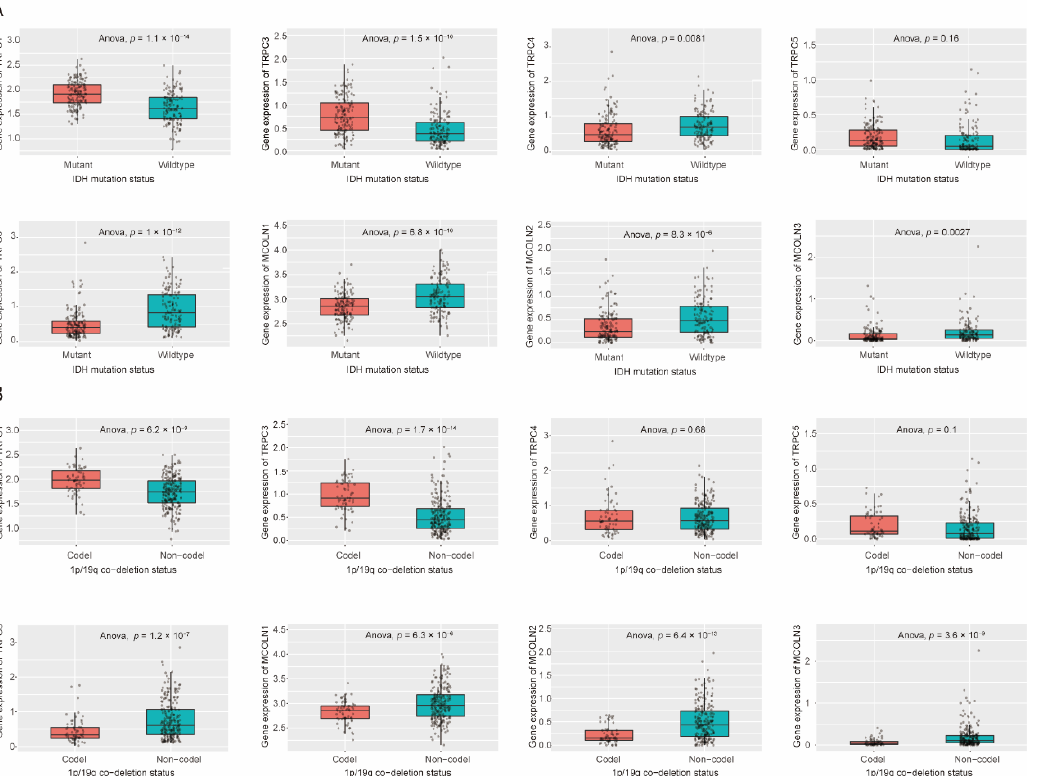
Figure 6. Expression of hub genes in IDH mutation status and 1p/19q codeletion status of glioma. ( A ) . Validation of hub gene expression levels of TRPC1, MCOLN1, MCOLN2, MCOLN3, TRPC5, TRPC4, TRPC3, and TRPC6 in different IDH mutations status of glioma using CGGA database. ( B ). Validation of hub gene expression levels of TRPC1, MCOLN1, MCOLN2, MCOLN3, TRPC5, TRPC4, TRPC3, and TRPC6 in different 1p/19q codeletion status of glioma using CGGA database. The bottom and top of the boxes are the 25th and 75th percentiles, interquartile range. The statistical difference between the two subgroups was compared through the Kruskal–Wallis test, respectively.